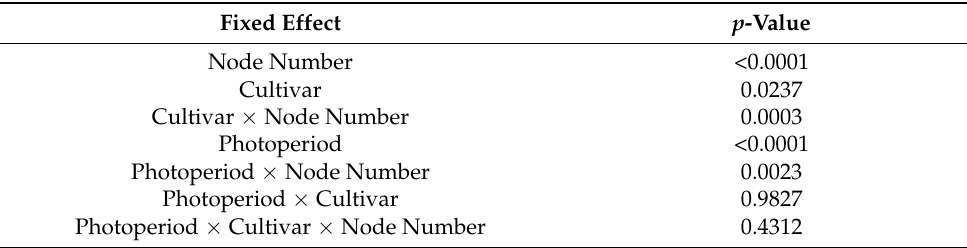
Table 1. Analysis of variance (ANOVA) for node number, cultivar, photoperiod, and their interaction on the node appearance rate (NdAR) from the second to the fifth main stem node.